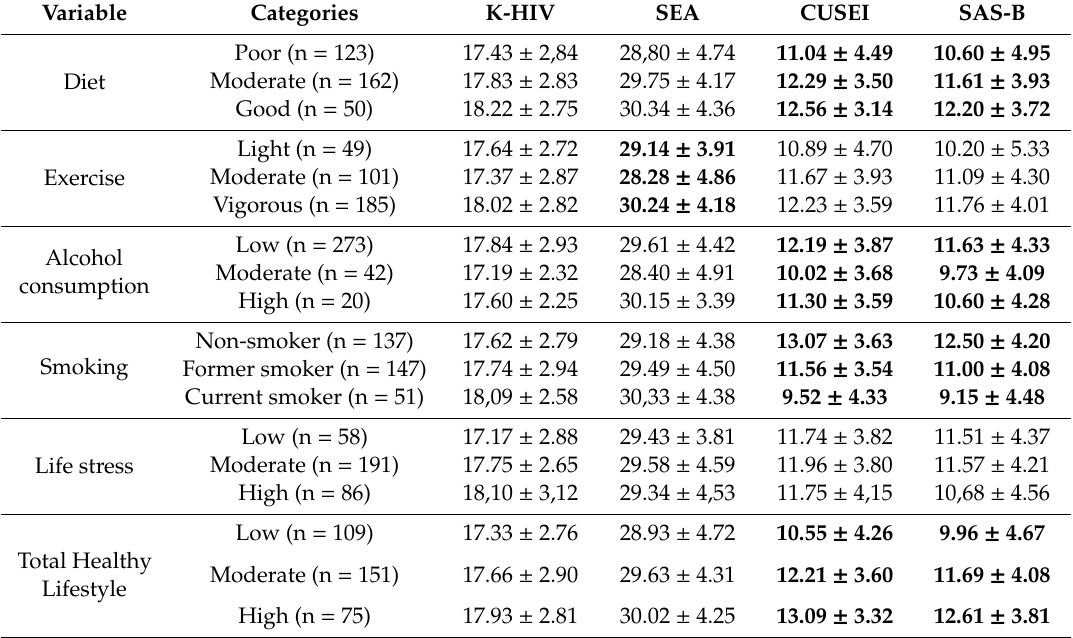
Table 4. Di ff erences in the main dimensions of risk of HIV infection between participants based on